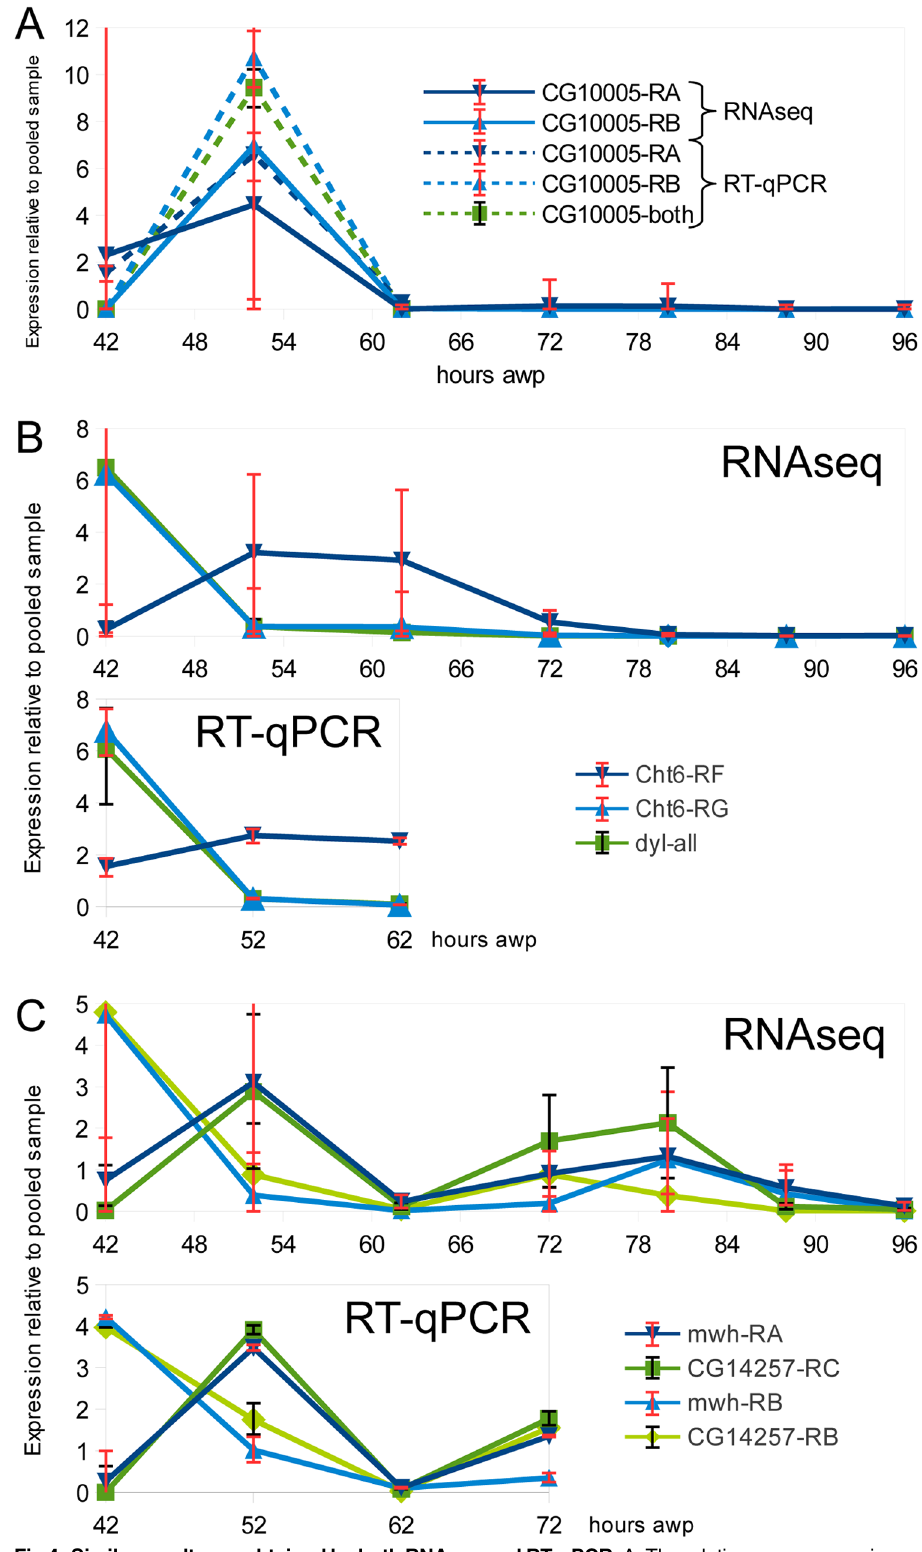
Fig 4. Similar results are obtained by both RNAseq and RT-qPCR. A. The relative gene expression patterns for the two mRNAs encoded by the CG1005 gene. Note the similar pattern seen with both RNAseq and RT-qPCR. B. The expression pattern for dyl and two isoforms of Cht6 . Note that Cht6-RG expression follows a similar pattern to dyl . C. The expression patterns for two isoforms of mwh and CG14257